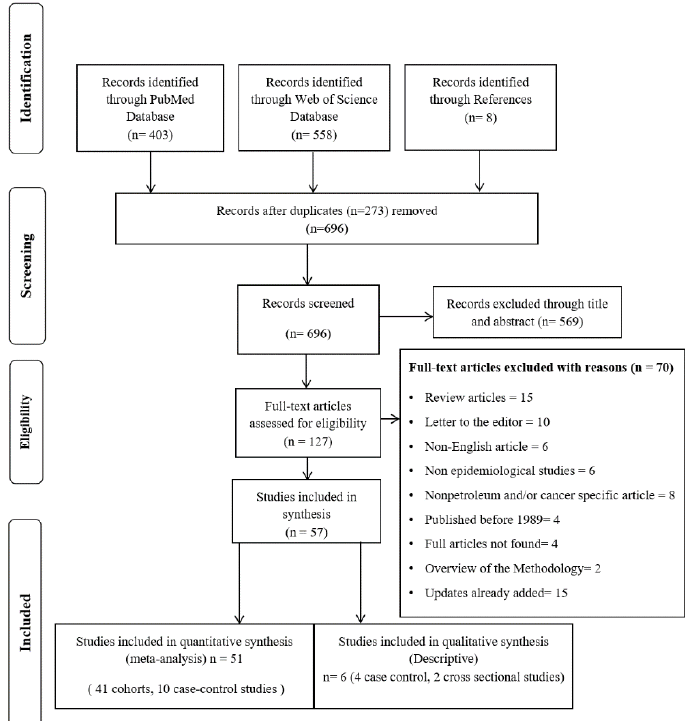
Figure 1. PRISMA Flow Chart of papers included in this systematic review and meta-analysis of cancer incidence and mortality among petroleum industry workers and residents living in oil pro- ducing